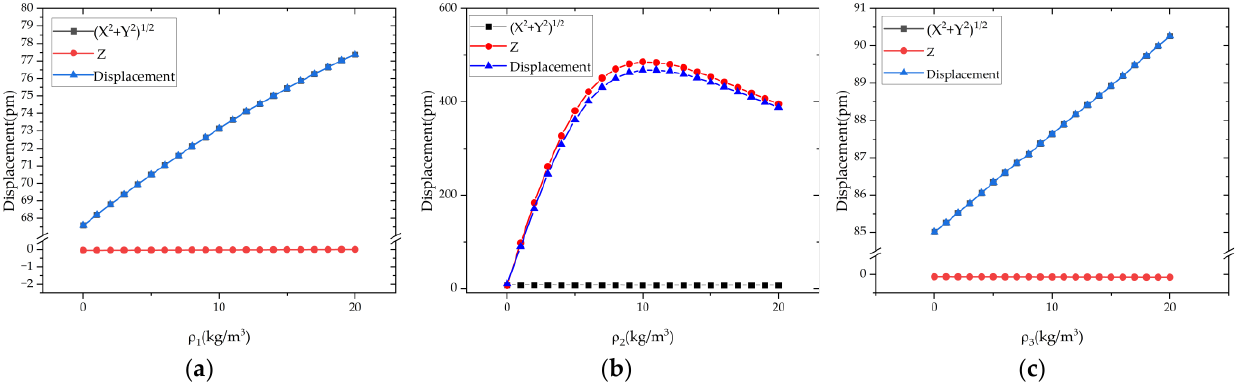
Figure 9. The influence of the first three harmonics ρ 1,2,3 on the displacement of the center of the cylindrical resonator bottom plate: ( a ) ρ 1 ; ( b ) ρ 2 ; ( c ) ρ 3 .